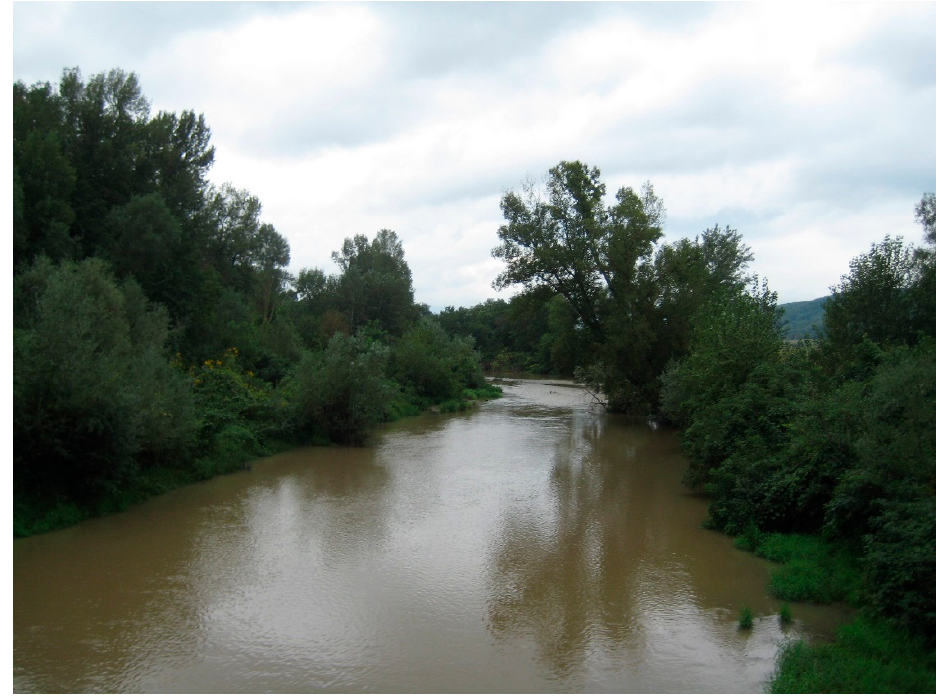
Figure 2. The Beli Timok at Timacum Minus (photo by L. Diers).